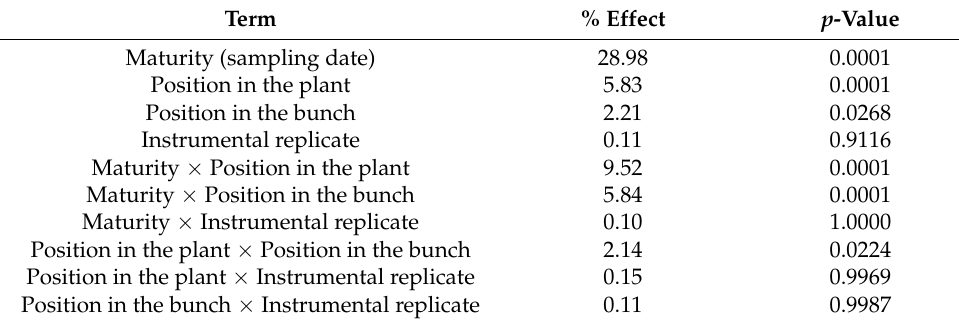
Table 3. Main effects and their combinations for the ASCA model.